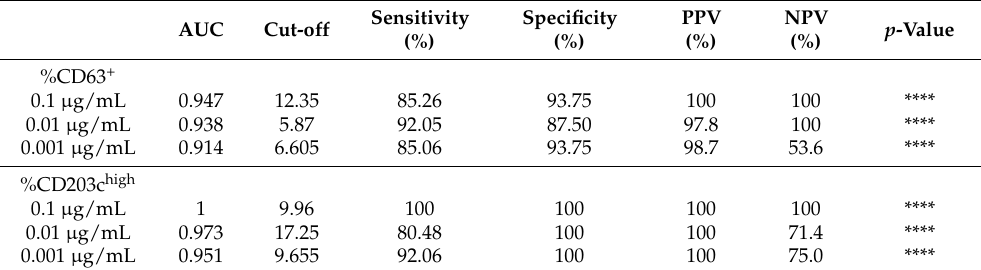
Table 2. ROC curve parameters of % CD63 + and % CD203c high from Pru p 3. AUC